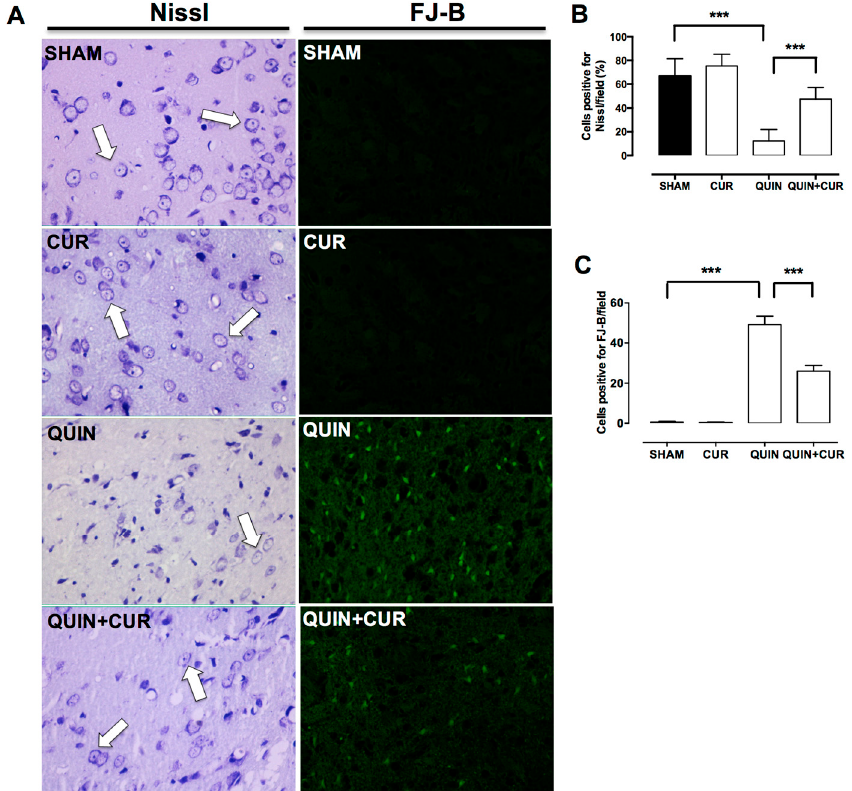
Figure 3. Effect of curcumin (CUR) on quinolinic acid (QUIN)-induced histological damage. Histological analysis was evaluated at day 7 after the QUIN injection. A representative photomicrograph (40×) of each group of the right striatum for ( A ) Nissl and FJ-B staining are presented. White arrows indicate cells positive for Nissl. Quantification of the percentage (%) of ( B ) cells positive for Nissl/field and ( C ) cells positive for FJ-B/field, counted in three randomly selected fields along the right striatum are presented. Data are expressed as mean ± SEM (n = 5 for FJ-B and n = 3 for Nissl staining). *** p < 0.001.